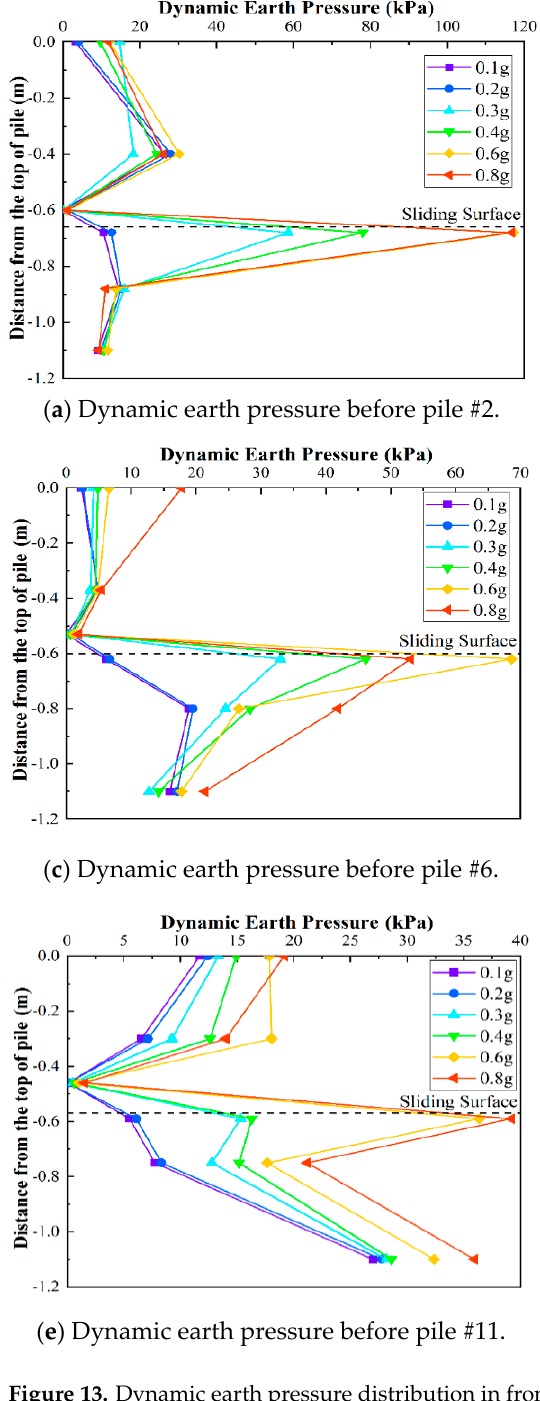
Table 5. The earth pressure sharing ratio of each row of piles (shaking table test).